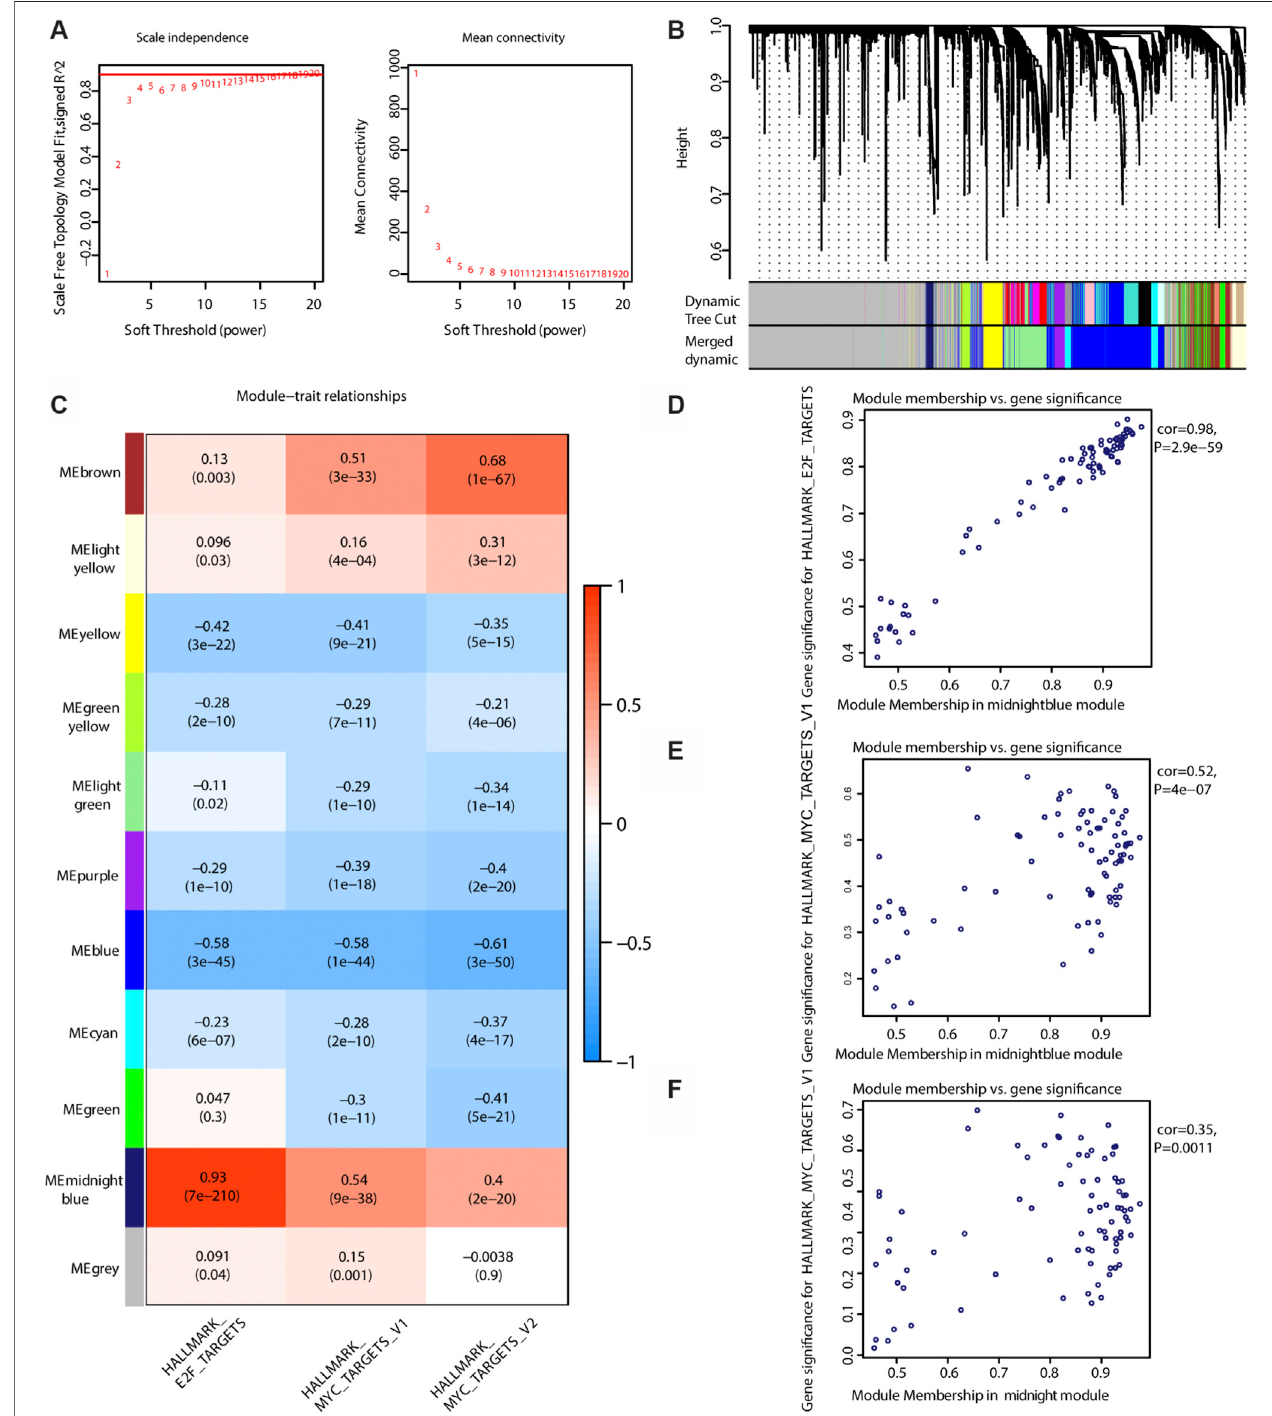
FIGURE6| WGCNAto fi ndthegenesforthedevelopmentofthemodel. (A) TherelationshipofsoftthresholdandTOM-baseddissimilarity (left) .Therelationshipof softthresholdandmeanconnectivity (right) . (B) Afterthedynamicofcutandmerged,atotalof11genemoduleswere fi nallygenerated. (C) Heatmapforthecorrelation ofgenemodulesandphenotypes. (D) Thescatterplotshowsthegenesigni fi canceforE2FssGSEAscoreiscorrelatedwithmodulemembershipinmidnightbluemodule (Pearson rho (cid:2) 0.98, p < 0.01). (E) Thescatter plotshows the genesigni fi cance for MYC_V2 ssGSEA scoreiscorrelated withmodule membership in midnightblue module (Pearson rho (cid:2) 0.35, p < 0.01). (WGCNA, weighted correlation network analysis; TOM, topological overlap matrix. And p < 0.05 is de fi ned as statistically signi fi cant).